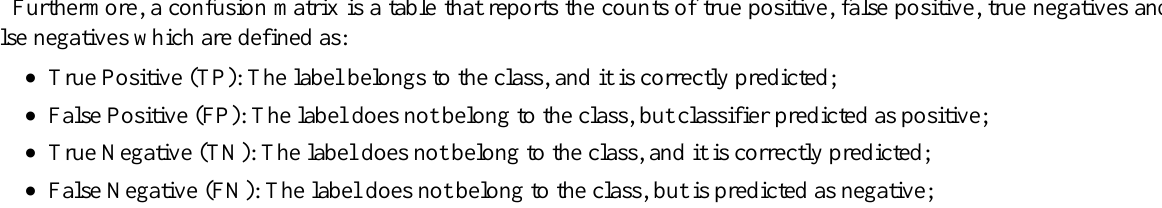
Figure 4. Metrics assessment